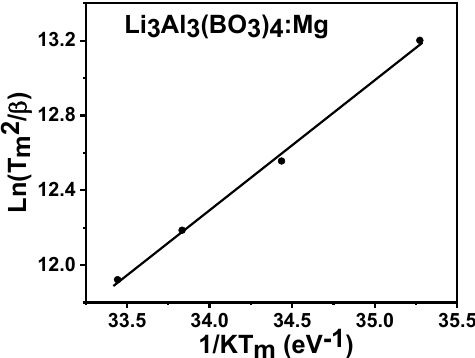
Figure 12. The heat rate plot for Mg ‐ doped lithium aluminium borate.